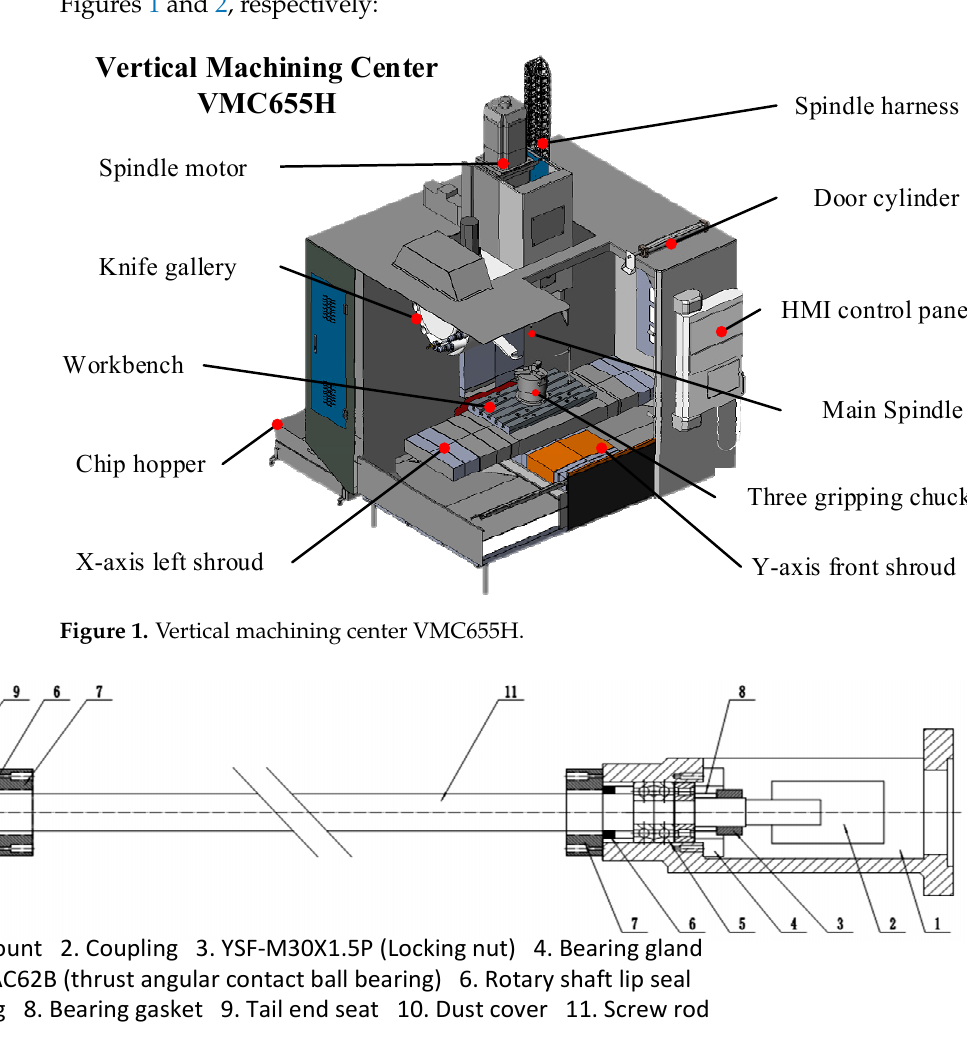
Figure 2. Schematic sketch of the feed shaft drive method. The machine table adopts a Cartesian coordinate layout form. Its motor, ball screw sub, guide sub, bearing, and slider are the primary heat sources in the process of machine motion, and the deformation of the screw is also related to its preload form. The feed axis adopts the three-coordinate separated drive. The AC digital feed servo motor is connected to the ball screw through a coupling to drive the moving parts to make a linear reciprocating motion. The feed axis is mounted with one end moving and one end fixed. The angular contact bearing is installed